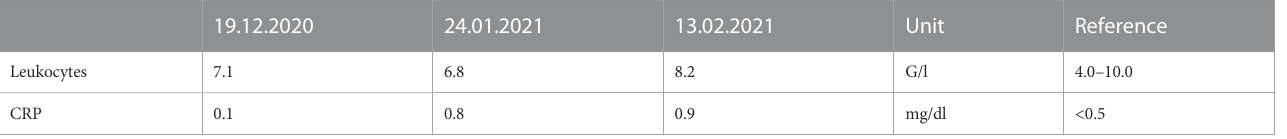
TABLE 2 History of the followingblood values of the high-risk patient: C-reactive protein (CRP) and leucocytes. In red highlighted is the CRP increase during COVID-19 infection.